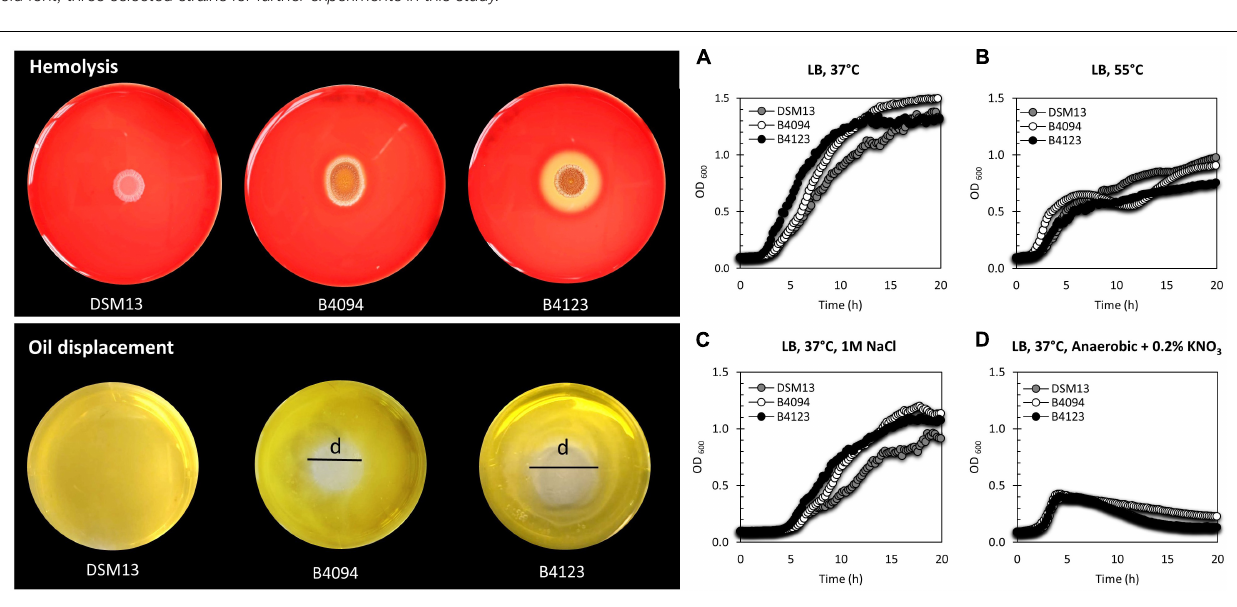
B4089 chromosomal DNA as a template; data not shown) ( Supplementary Table S3 ). Based on lichenysin production and the positive PCR results, the available genome sequence of B4089 may be